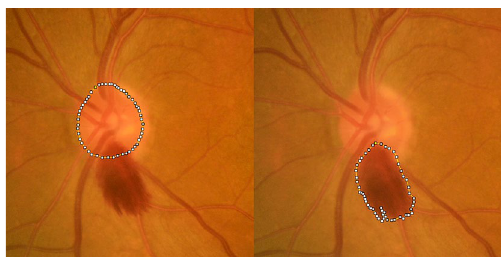
Figure 2. Measurement of disc area (DA) and disc hemorrhage (DH) area. Margins of the optic disc and disc hemorrhage are plotted and areas are measured. In this eye, the DH/DA ratio is